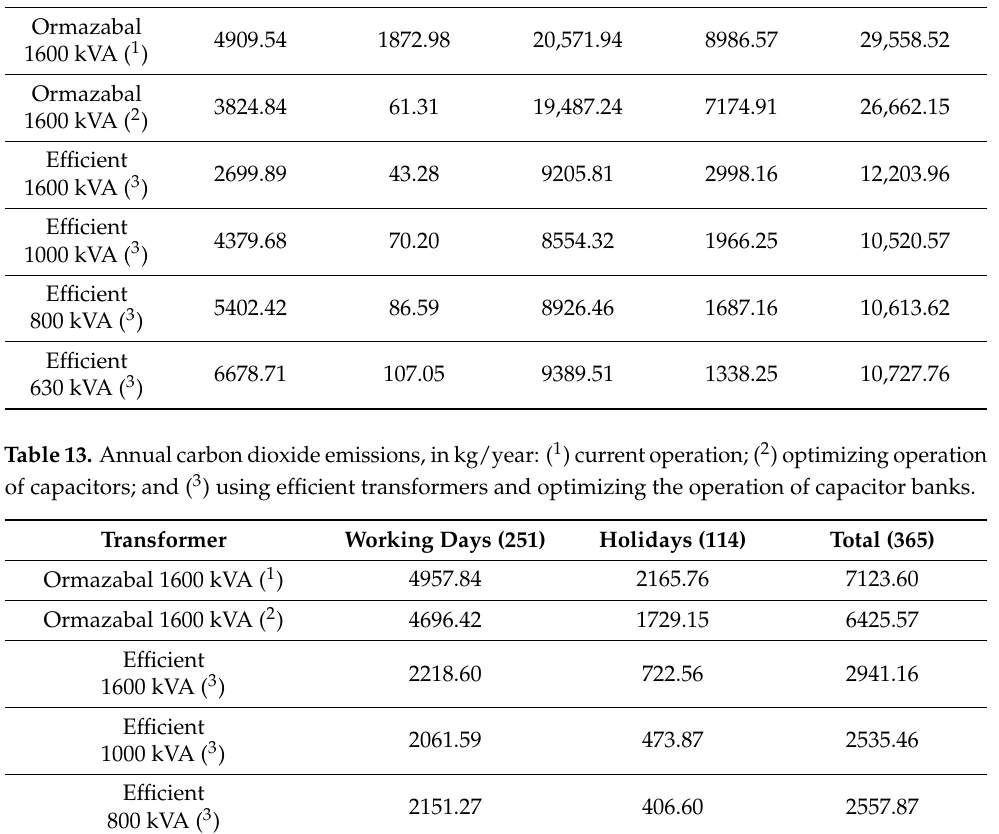
Table 12. Annual copper losses ( W